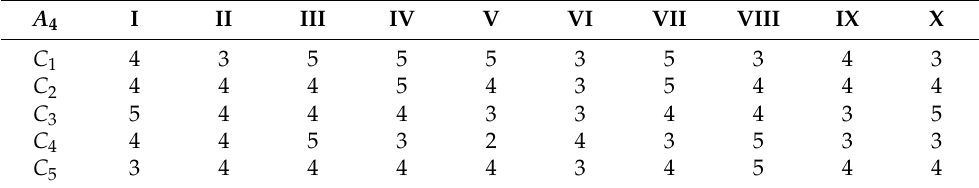
Table 6. Ratings of alternative A 5 in relation to the evaluation criteria obtained from 10 respondents.